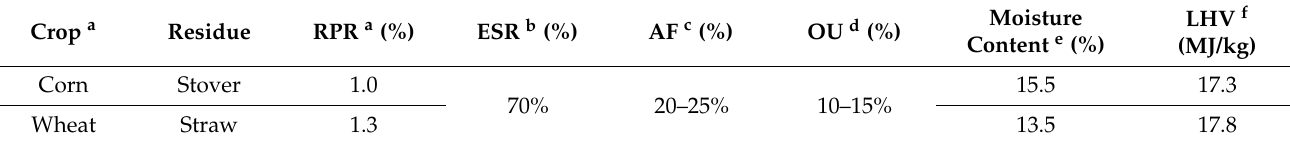
Table 4. Parameters considered for corn and wheat residues potential estimates in the US. Notes: a : Crop production obtained in the U.S. National Census of Agriculture [49]; b : [48,50]; c : 30% residue cover is reasonable for soil protection [48]; d : Other uses (OU) are mainly associated to animal feeding. According to [48] animals rarely consume more than 20–25% of the stover in grazing; e : About 10% to 15% of the crop residue is used for other purposes, such as bedding, silage, etc. [48]; f :